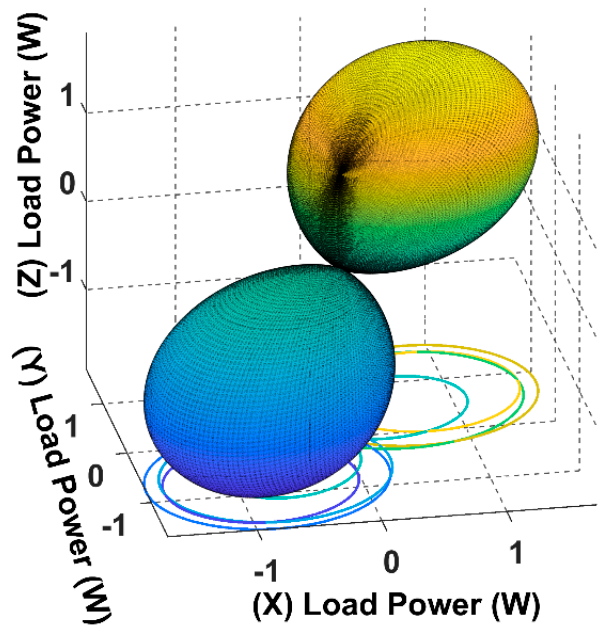
Figure 7. The power load spherical plot for the 3D WPT system when the receiver is placed at α = φ = 45°.